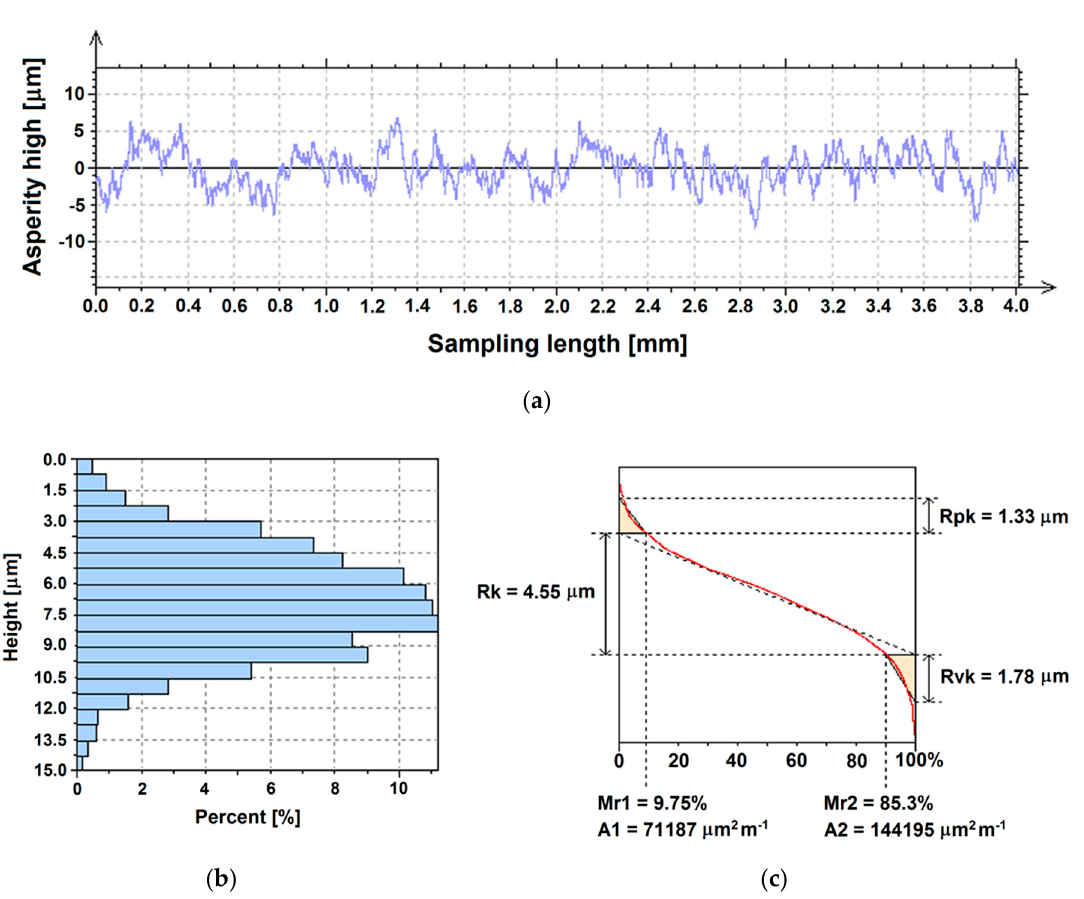
Figure 5. Sample profile recorded for the Ti G4 after sandblasting: ( a ) Roughness profile; ( b ) Distribution of the height ordinate; ( c ) Surface bearing area ratio curve.